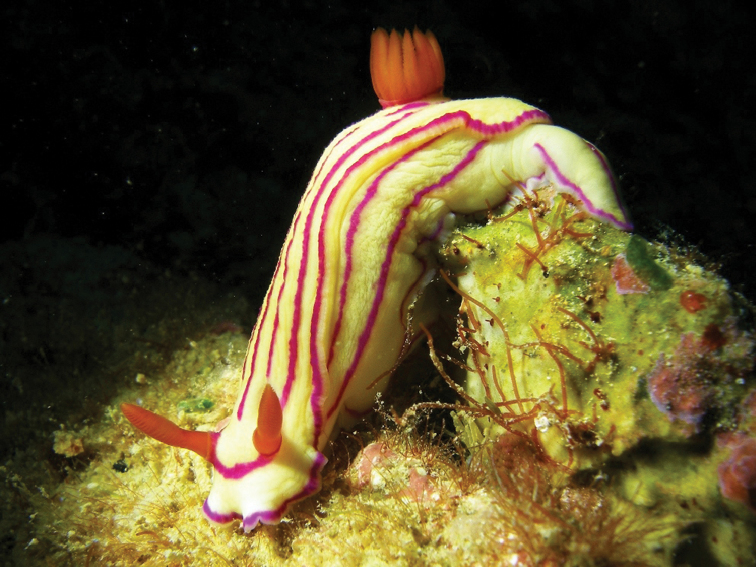

Hypselodoris
maridadilus Rudman, 1977, photograph S Kahlbrock.